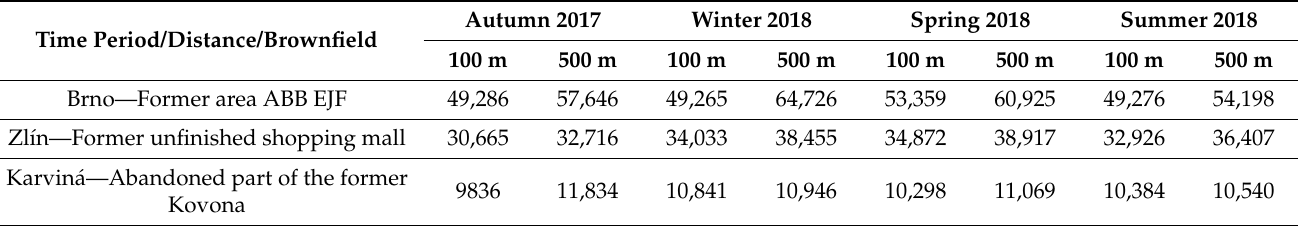
Table 4. The average price of real estate (in CZK/m 2 ) according to the distance from the analysed